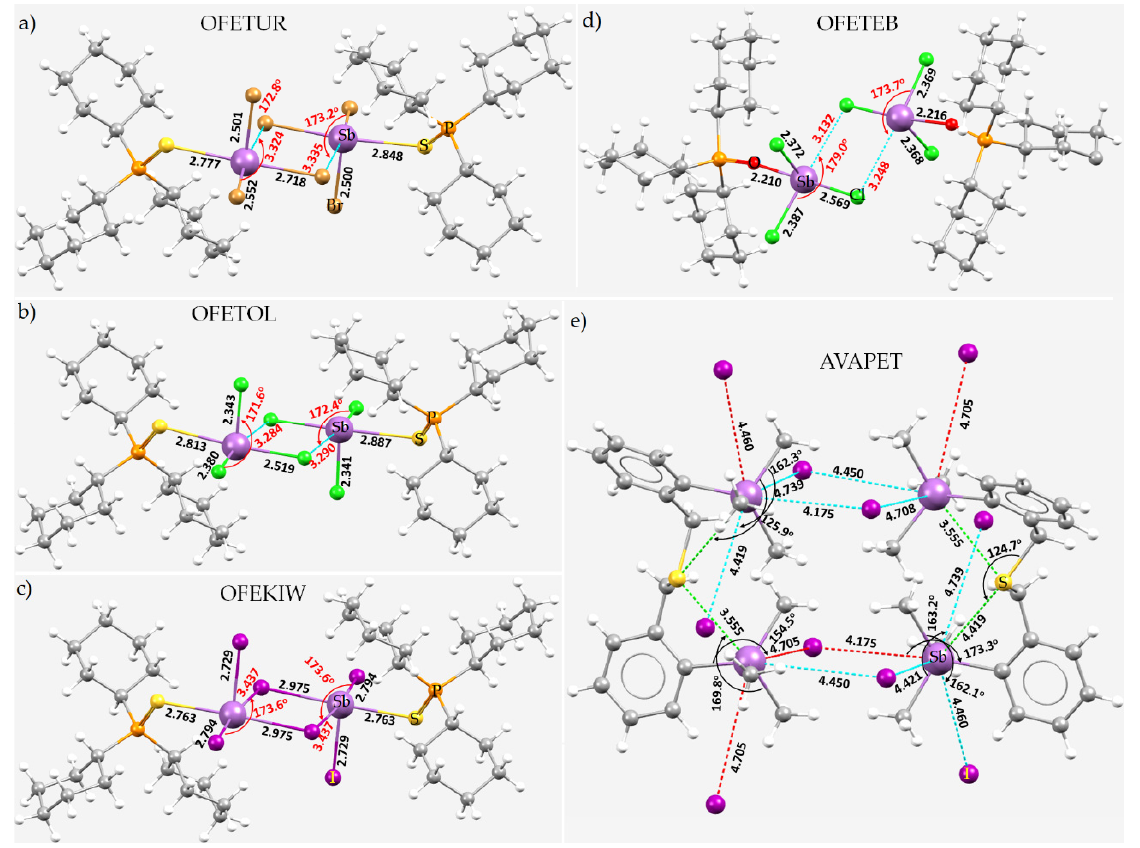
Figure 22. ( a ) The nature of the coordination environment around the Sb ion in the crystals of ( a ) (Cy 3 PS)SbBr 3 , ( b ) (Cy 3 PS)SbCl 3 , ( c ) (Cy 3 PS)SbI 3 , ( d ) (Cy 3 PO)SbCl 3 , and ( e ) [S(CH 2 -2-C 6 H 4 SbMe 3 ) 2 ]I 2 . Selected bond lengths and bond angled in Å and degree, respectively. Atoms are shown as small spheres and bonds as lines in atom color, whereas the intermolecular interactions are represented by dotted lines. Atom color: Sb—purple; O—red; Br—dark-red; C—gray; H—white-gray; P—orange; S—yellow; Cl—green. CSD ref. codes are shown. The structure of [S(CH 2 -2-C 6 H 4 SbMe 3 ) 2 ]I 2 , resulting from pnictogen bonding and ex- tensive other primary and secondary interactions, is shown in Figures 22e and 23 [155]. A representation of the ionic species, [S(CH 2 -2-C 6 H 4 SbMe 3 ) 2 ] 2+ ·2I − , is shown in Figure 23a, and the expanded crystal system is shown in Figure 23b. Since the pnictogen bonding is between (formally) ionic species, it is charge assisted.